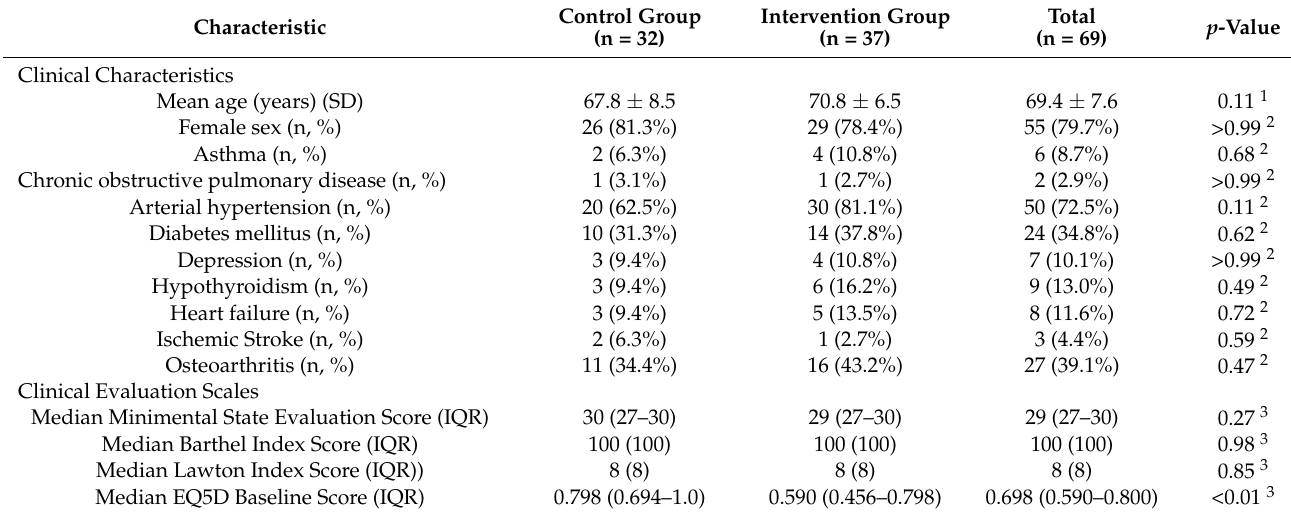
Table 1. Characteristics of the study sample.